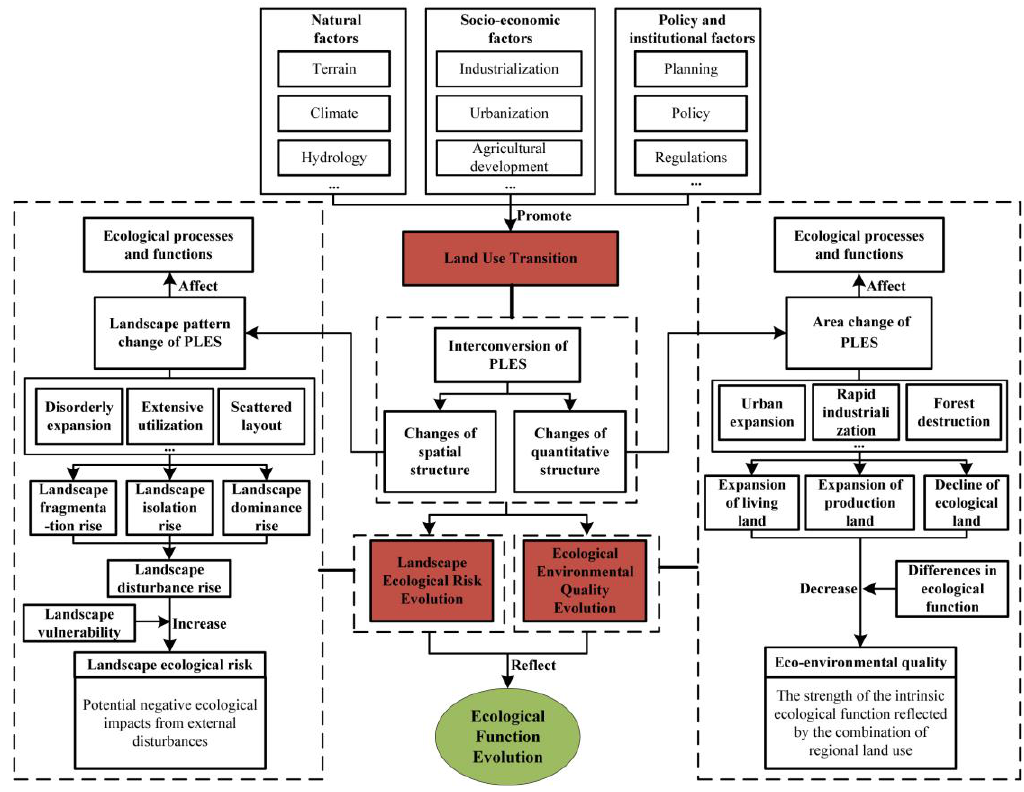
Figure 1. The proposed and applied research framework of eco-environmental effects caused by land use transition. use